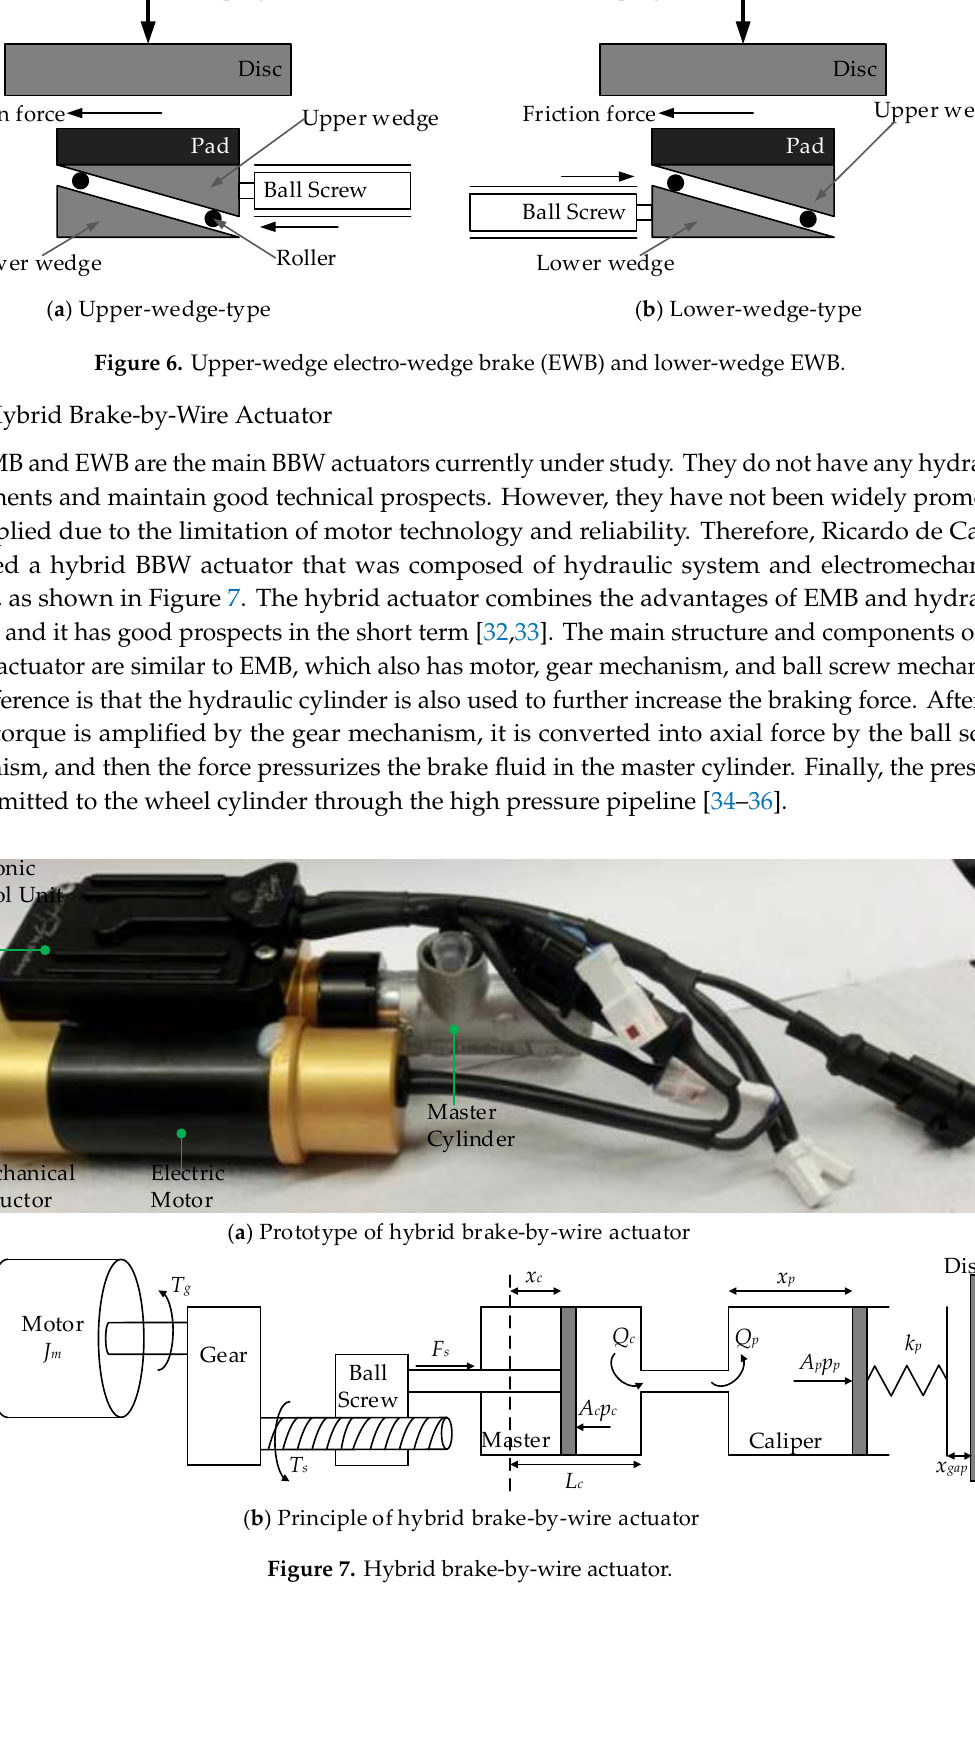
12: Pressure plate Figure 8. Direct-drive electro-hydraulic /electro-mechanical actuator.